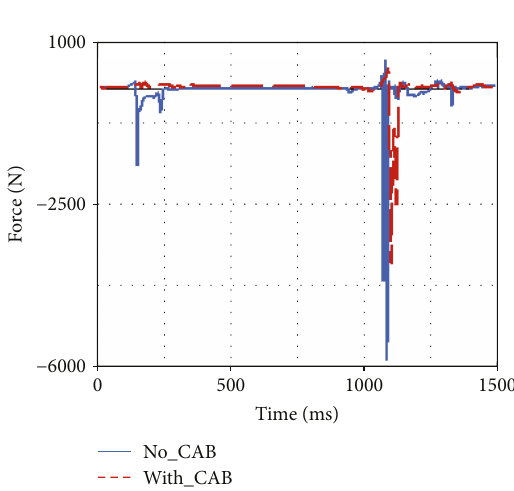
Figure 8: Chest resultant accelerations.